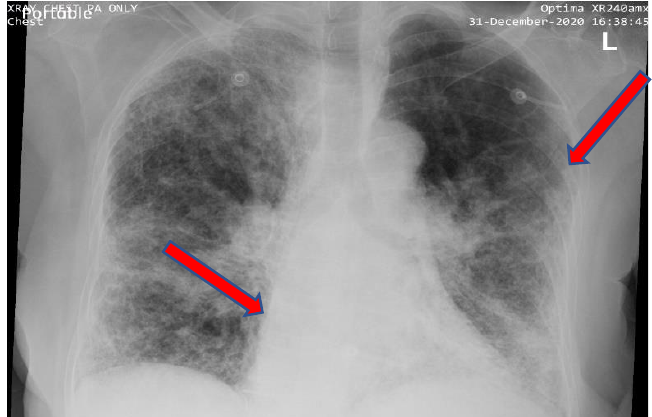
Figure 3. Pulmonary radiography of a person infected with COVID-19.